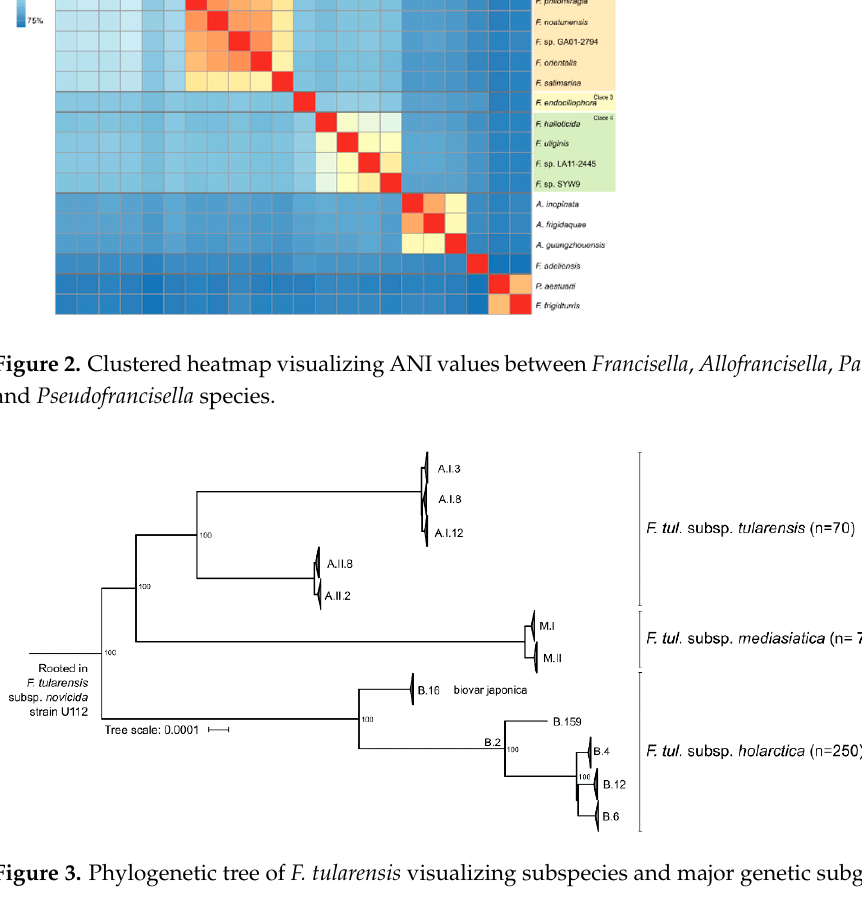
Table 2. Overview of genome distribution within clades and species, including detailed information about the number of unique regions for each species and pan/core genome size.